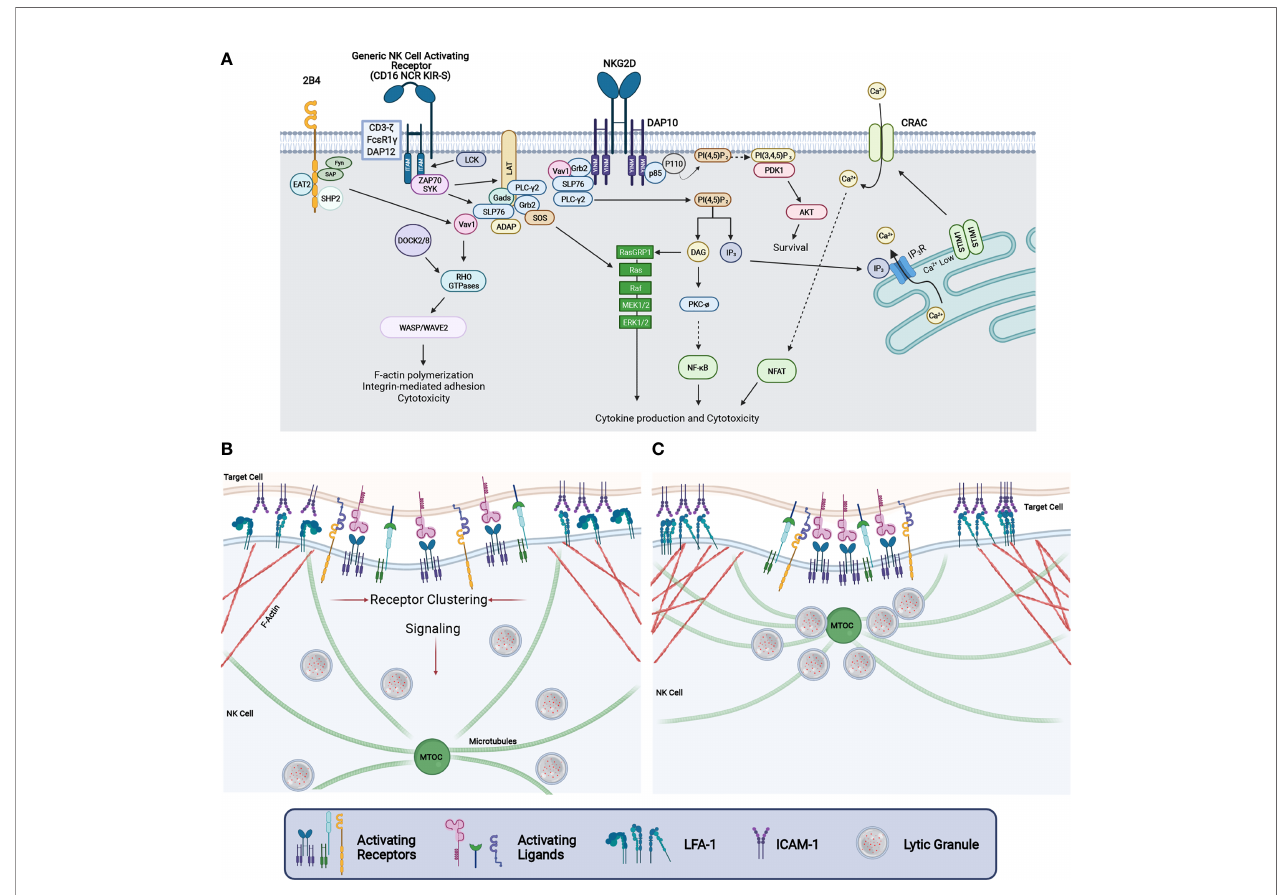
FIGURE 2 | NK cell signaling and cytotoxic synapse maturation. (A) Signaling diagram depicting events downstream from human NKG2D-DAP10, 2B4, and NK cell activating receptors coupled to the ITAM containing adaptor proteins CD3- z , FC ϵ R1 g , or DAP12. Ligation of these receptors causes VAV1, SLP76, and PLCy2 phosphorylation which results in the activation of NFAT through calcium release, NF k B activation, and activation of the MAP Kinase cascade. This ultimately leads to increased integrin-mediated adhesion, F-actin reorganization, cytokine production, and cytotoxicity. (B) Upon the binding of a target cell, signaling through NK cell activating receptors results in the clustering of receptors while simultaneously enhancing adhesion through integrin af fi nity maturation and directing LG convergence to the MTOC. (C) As the CS matures, activating receptors are clustered at the central region of the CS whereas F-actin and integrins accumulate in the peripheral region of the CS to stabilize adhesion between the NK and target cell. Further signaling from NK activating receptors drive LG convergence and MTOC